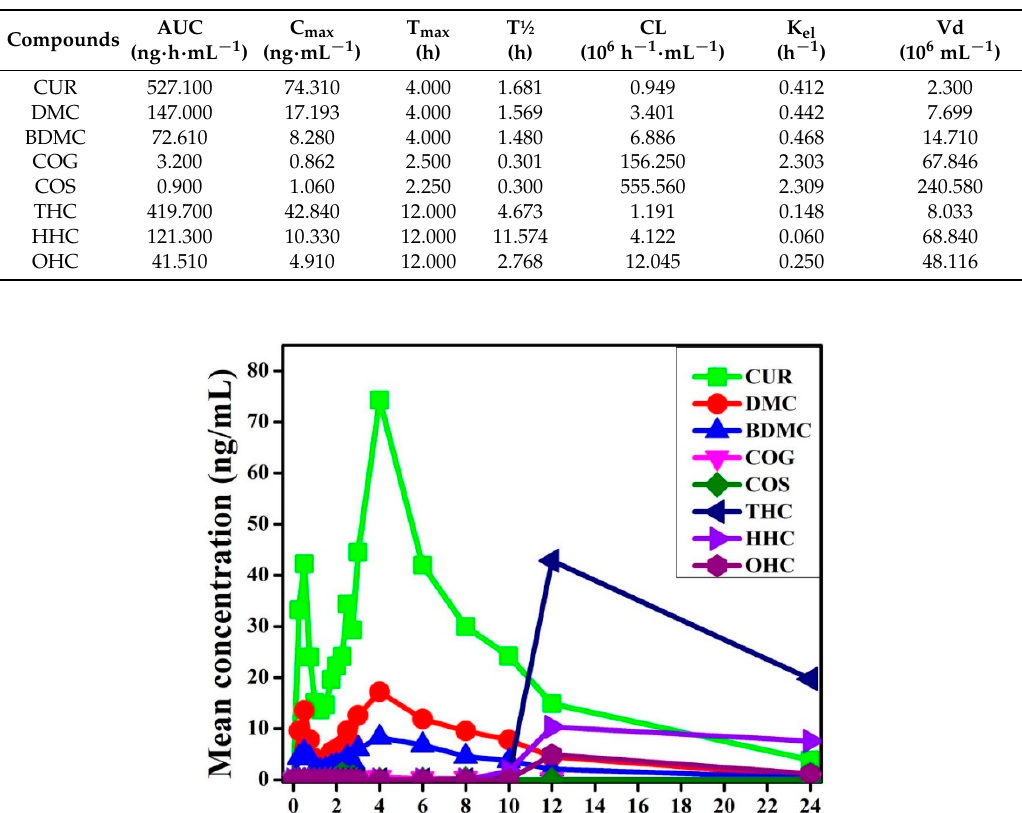
Table 4. Pharmacokinetic parameters of CUR, DMC, BDMC, COG, COS, THC, HHC and OHC after